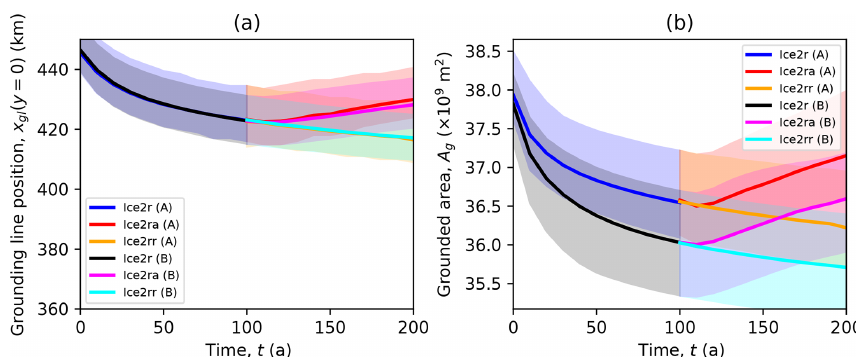
Figure 15. Midchannel grounding line position (a) and grounded area (b) plotted against time for the Ice2A and Ice2B models. The Ice2B models exhibit greater change in grounding line area than Ice2a, but that change is restricted to thin ice outside the channel.